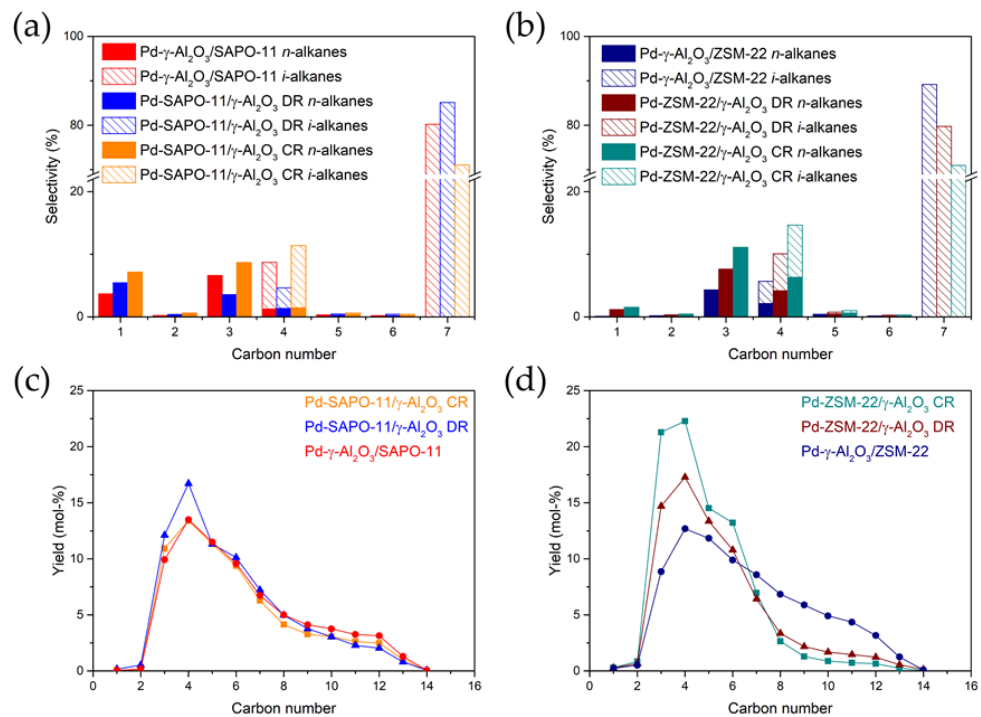
Figure 6. Distribution of products obtained during ( a ) hydroconversion of n -heptane over SAPO-11-based catalysts at 75–77% conversion, ( b ) hydroconversion of n -heptane over ZSM-22-based catalysts at 77–78% conversion, ( c ) hydroconversion of n -hexadecane over Pd-SAPO-11/ γ -Al 2 O 3 (orange squares at T = 340 ◦ C), Pd- γ -Al 2 O 3 /SAPO-11 (red circles at T = 350 ◦ C) and Pd-SAPO-11/ γ -Al 2 O 3 DR (blue triangles at T = 380 ◦ C) at 26–28% cracking yield and ( d ) hydroconversion of n -hexadecane over Pd-ZSM-22/ γ -Al 2 O 3 (cyan squares at T = 340 ◦ C), Pd- γ -Al 2 O 3 /ZSM-22 (dark blue circles at T = 320 ◦ C) and Pd-ZSM-22/ γ -Al 2 O 3 DR (brown triangles at T = 330 ◦ C) at 25–32% cracking